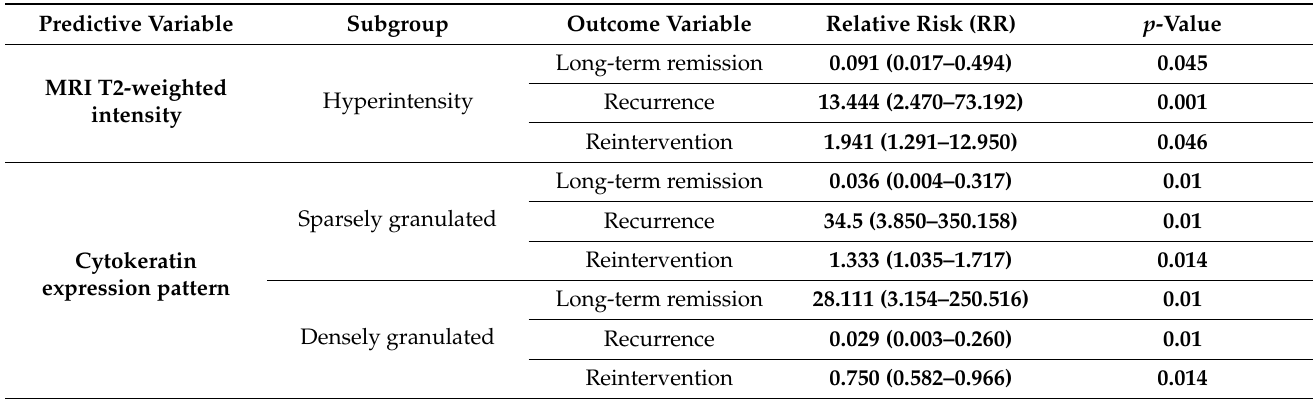
Table 3. Univariate analysis is presented. Each subgroup of the predictive variables analyzed is presented according to its statistically significant relation to the outcome variables (remission, recurrence, and reintervention) through Relative Risk and p -Value.